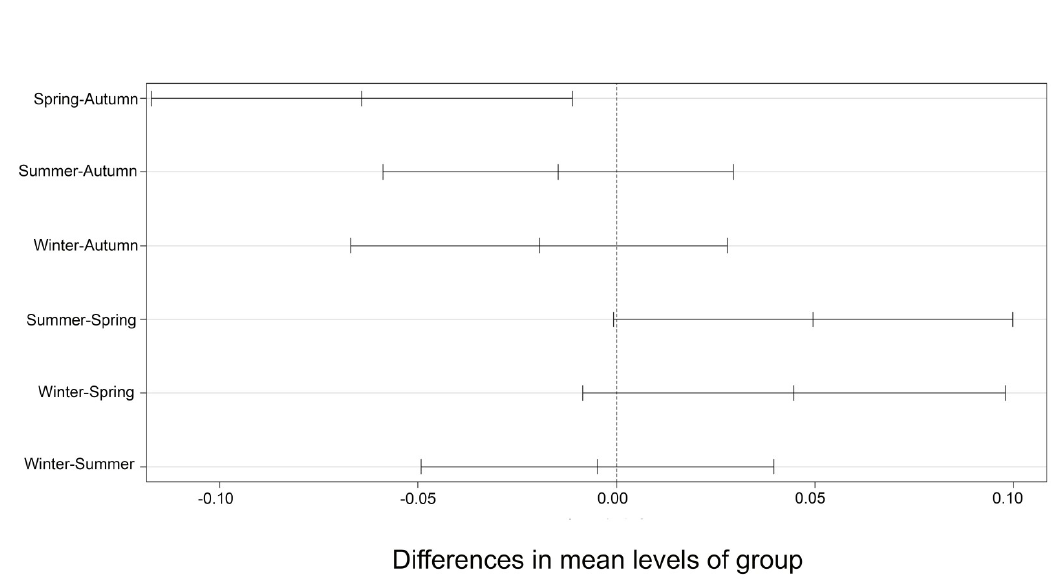
Figure 7. Tukey test results of the permutational analysis of multivariate dispersions (PERMDISP) applied to the diet data of Serrapinnus notomelas in the autumn, spring, summer, and winter